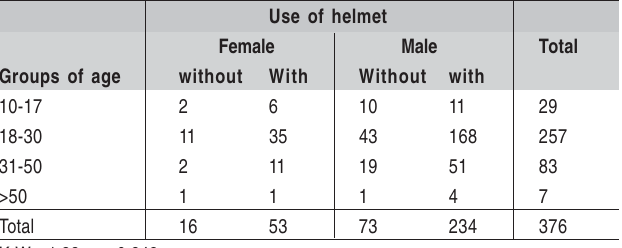
Table 1. Distribution of facial trauma according to gender and year groups.